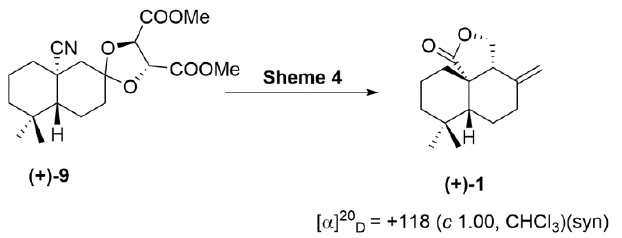
Scheme 5. Synthesis of (+)-antrocin 1.